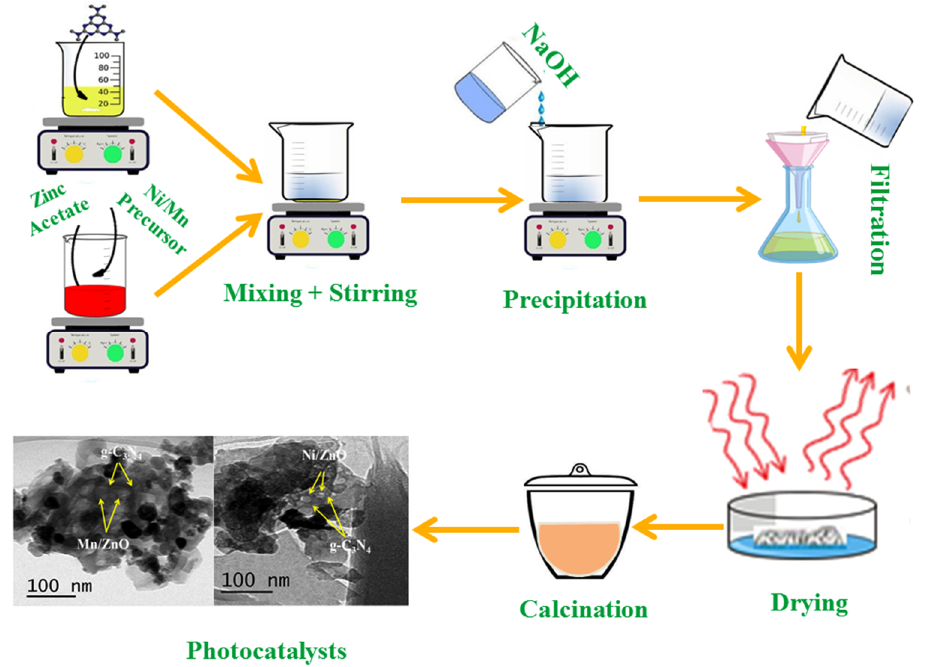
Figure 1. Schematic description of the synthesis of metal/g-C 3 N 4/ ZnO nanocomposites.